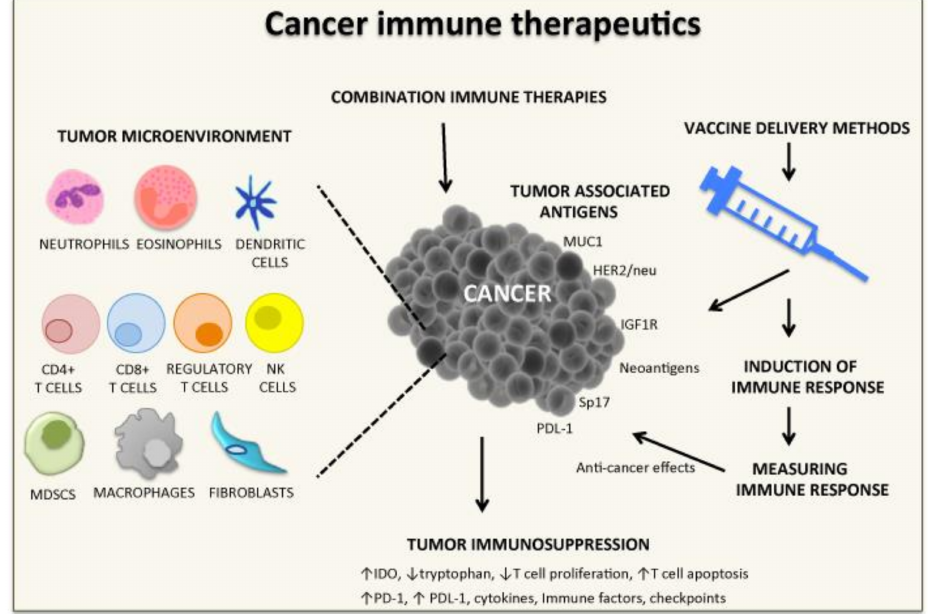
Figure 1. Strategies for cancer vaccine development. Strategies presented in this special issue on Cancer Vaccines: Research and Applications. CD, cluster of di ff erentiation; HER1 / neu, Human Epidermal Growth Factor Receptor 2; IDO, Indoleamine-2,3-dioxygenase; IGF1R, insulin-like growth factor receptor-1; MDSCS, Myeloid-derived suppressor cells; MUC1, Mucin 1; NK, natural killer; PD-1, programmed death-1; PDL-1, program death ligand 1; Sp17, cancer testis sperm protein